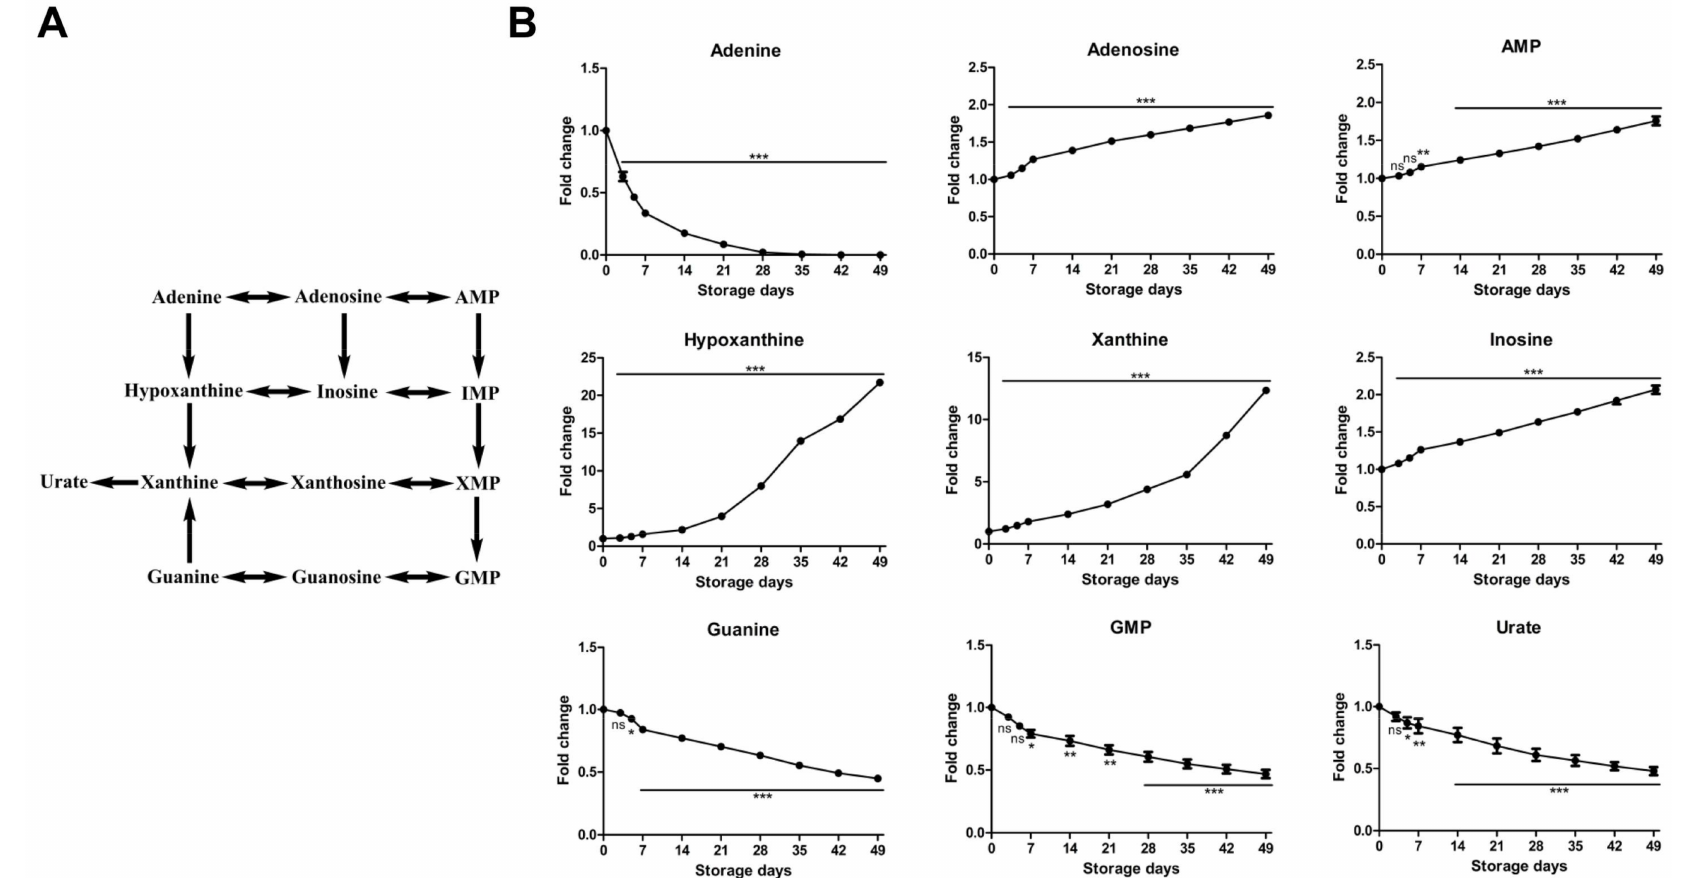
Figure 5. An overview of purine metabolism ( A ) and time-course changes of metabolites involved in this pathway ( B ) during RBC storage in MAP. Fold change was normalized against day 0 controls. Data are mean ± SD ( n = 8); * p < 0.05, ** p < 0.01, *** p < 0.001, ns (not significant), compared with day 0